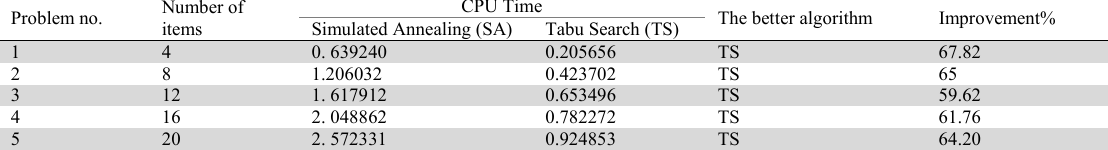
The required CPU time of the algorithms in fuzzy mode Problem no. The better algorithm